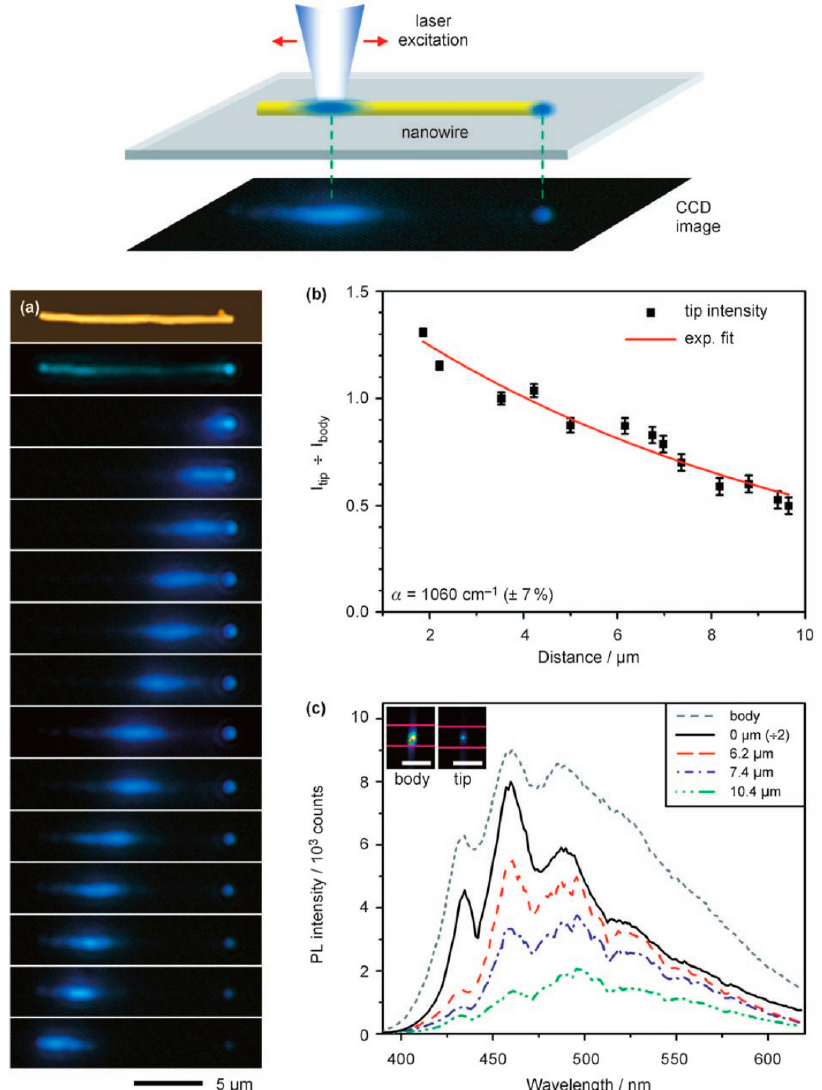
Figure 3. Fluorescence waveguide properties of the prepared poly(9,9-dioctylfluorene) (PFO) nanofiber. Top panel: Schematic diagram of the single nanofiber fluorescence waveguide setup. ( a ) Atomic force microscopy (top image) and fluorescence microscopy (second image from top) images. Fluorescence microscopy images obtained as a laser excitation spot at different positions along the same PFO nanofiber (bottom 13 images). ( b ) Data of I tip / I body versus different propagation distances and the exponential fit for the fluorescence waveguide ( I is shorted for the fluorescence intensity). ( c ) Photoluminescence (PL) spectra of outcoupled emission from the tip of the PFO nanofiber for different propagation distances (the whole Figure 3 was reprinted with permission from O’Carroll et al. [40]).